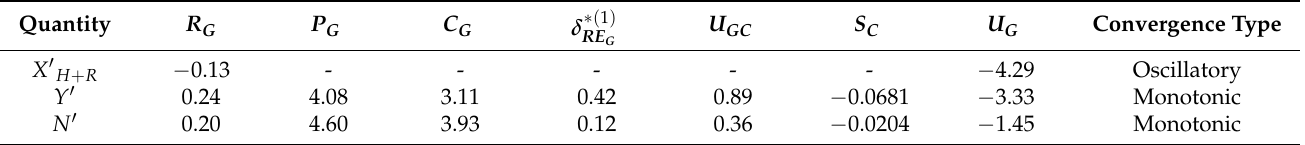
Table 8. Grid uncertainty analysis for static drift motion by double-body flow simulation. δ and U G are % S 3 .